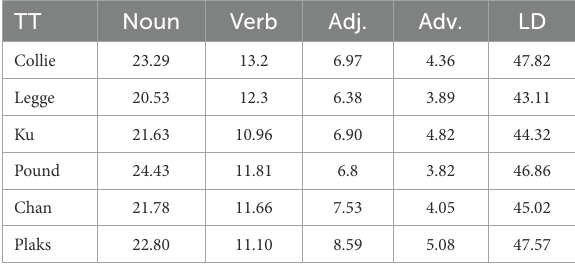
TABLE 5 Tagging statistics and LD of the six TTs (in